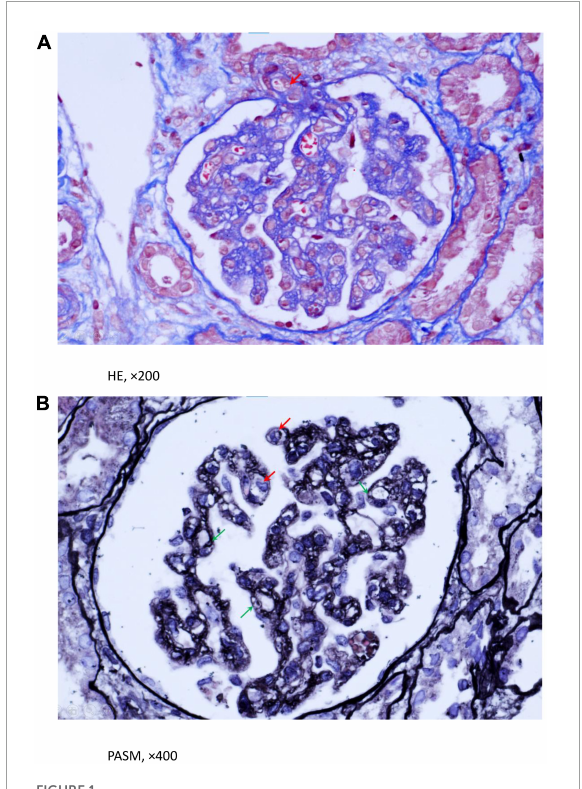
FIGURE1 (A,B) Light microscopy evaluation of renal biopsy using HE and PASM staining. A. HE staining implied that some lumen occlusion and intima edema was in partial afferent arteriole (Red arrowhead). (B) PASM staining showed endotheliocytes were swollen and proliferative, partial capillary loops were compressed and narrowed (Red arrowhead), GBM were incrassated and degenerated, with lamina rata internal expansion and formation of double contours (Green arrowhead). (A) (HE, × 200), (B) ( PASM, × 400).